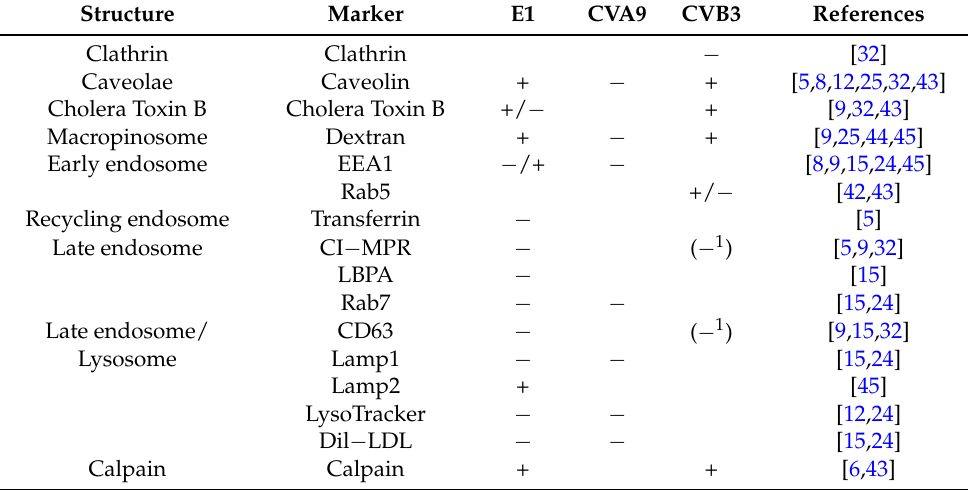
Table 2. Colocalization of endosomal structures or proteins associated with E1, CVA9 and CVB3.